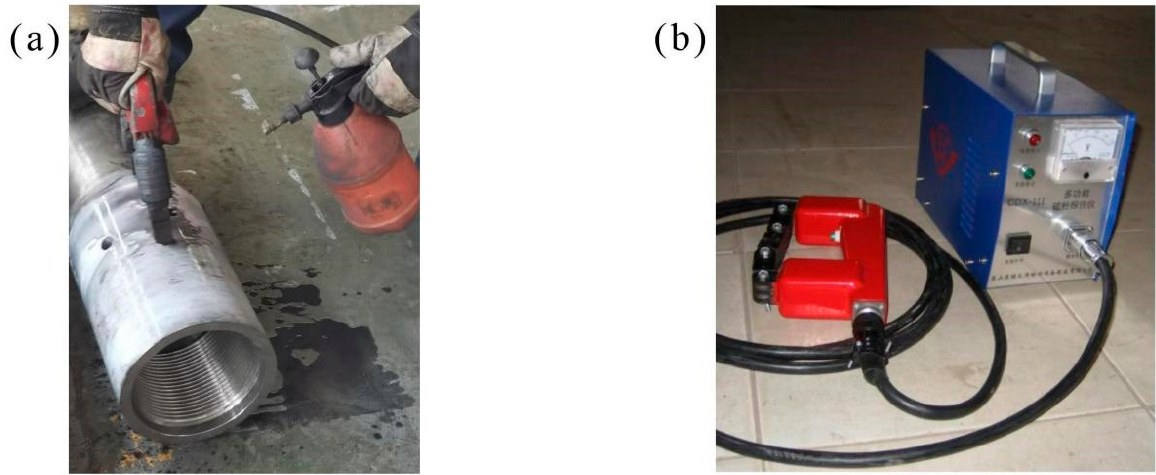
Figure 2. Torsion test flaw detection process and equipment. ( a ) Flaw detection process; ( b ) flaw detection equipment.